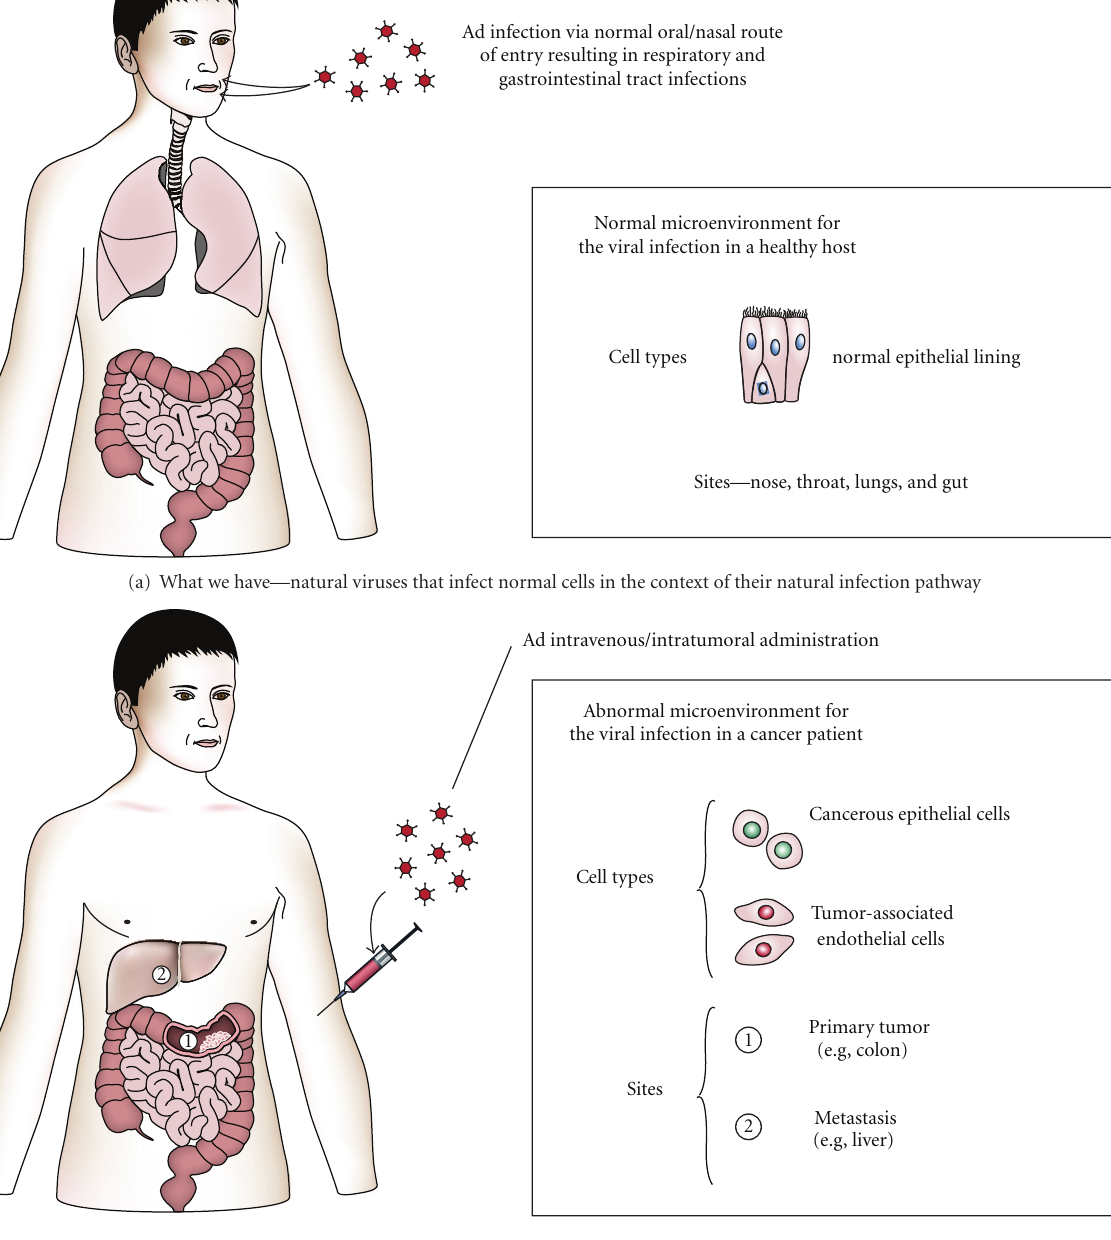
Figure 1: Why we need directed evolution. (a) The starting point of all oncolytic viruses are naturally occurring viruses which infect normal cells they encounter along their standard route of entry. (b) The goal is to develop oncolytic viruses which selectively infect and replicate in cells they would never naturally